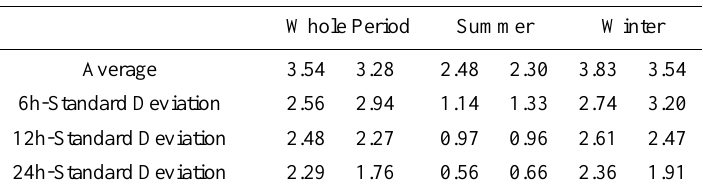
Table 2. Variability comparison of the MM5 predictions and wind profiler measurements. Table reports average and 6–12–24h standard deviation coefficients for WP and MM5 time